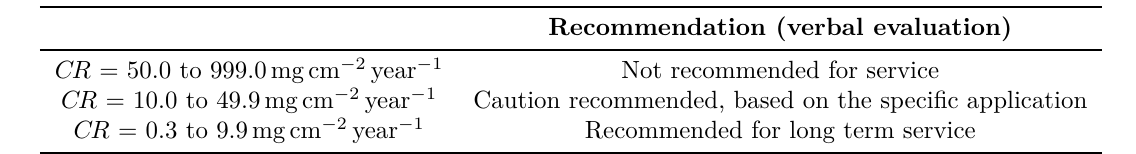
Table 3. The Guide for corrosion weight loss used in industry (the selected limit values) [2–4].